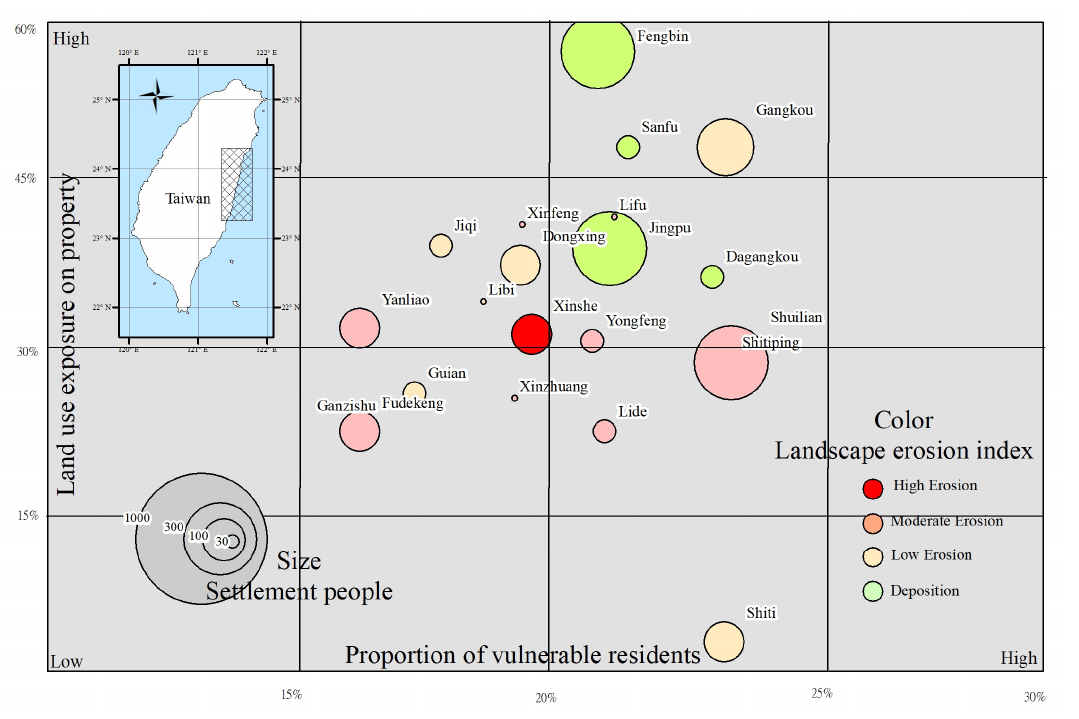
Figure 4. Coastal settlement vulnerability assessment on the eastern side of Taiwan